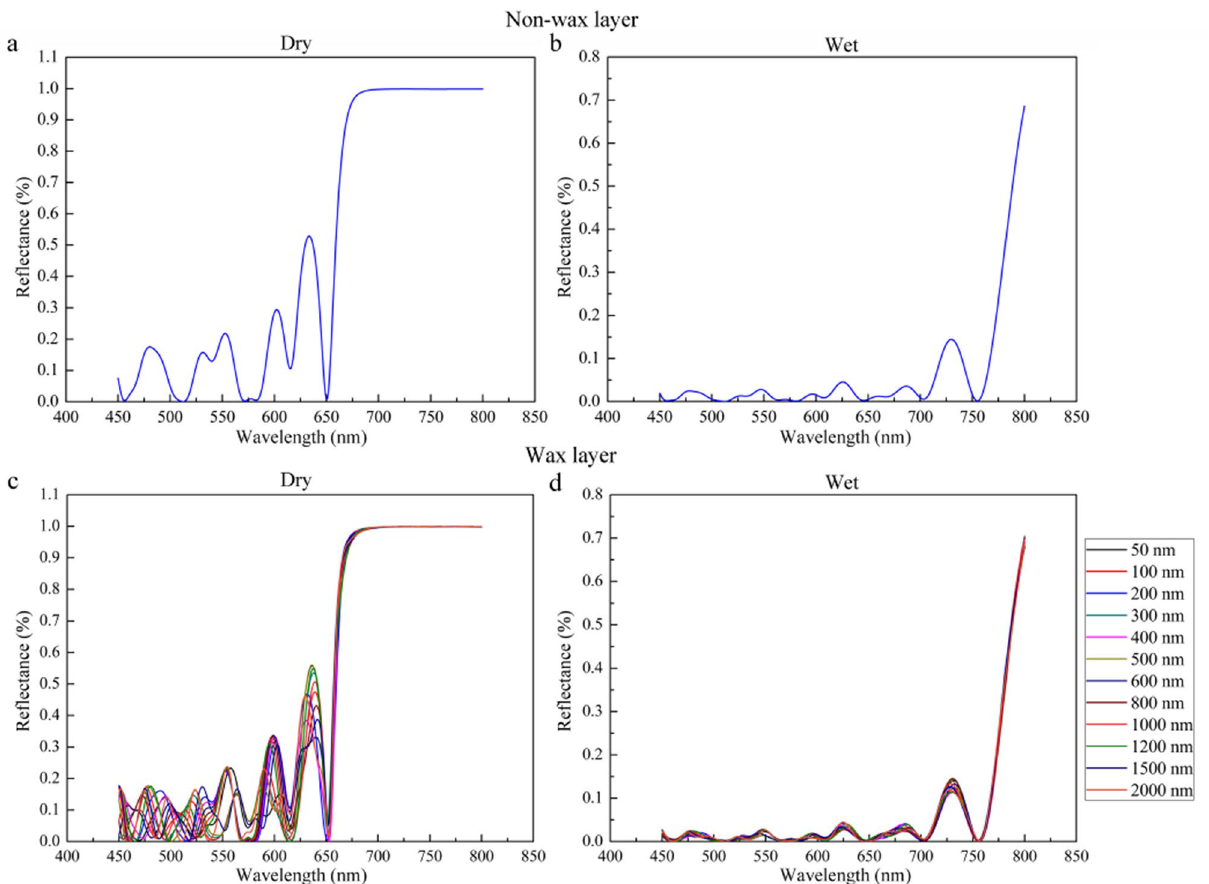
Figure 5. Simulated reflectance spectra of the multilayer unit model at an incidence angle of 0°. Non-wax layer in dry ( a ) and water-infiltrated ( b ) states. Addition of a wax layer on top of the outermost EPI and variation in its thickness in the dry ( c ) and water-infiltrated ( d )